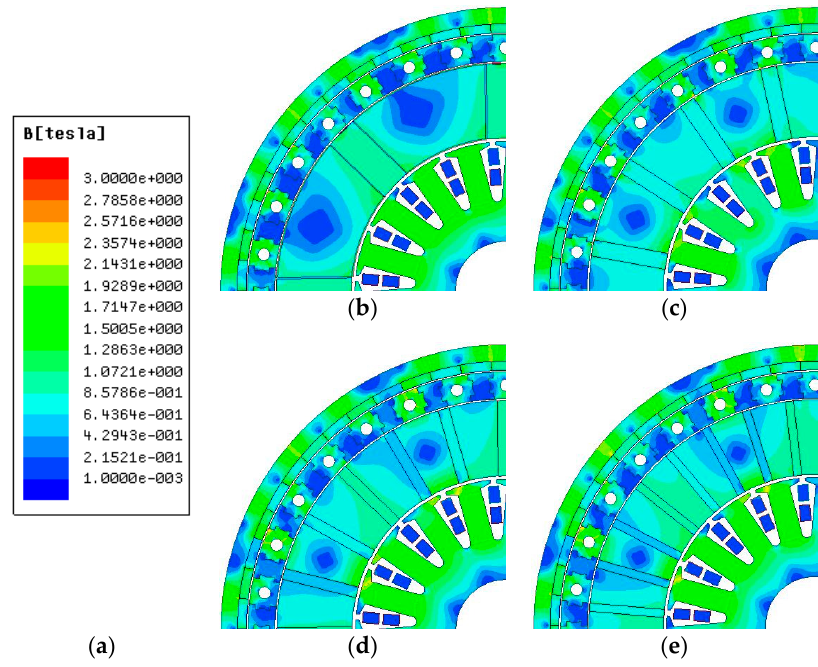
Figure 8. Flux density of four spoke-type structures with no load: ( a ) scale ( b ) one segment; ( c ) two segments; ( d ) three segments; and ( e ) four segments.